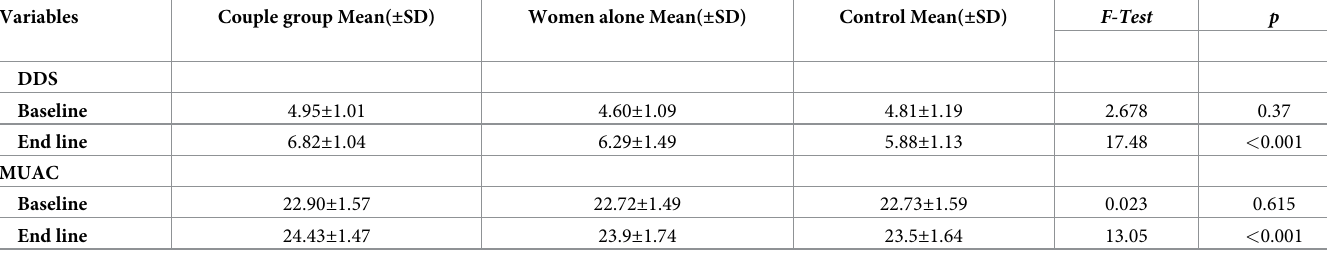
Table 2. Comparison of the Mean DDS and MUAC among the pregnant women ILU Aba Bor Zone, Southwest Ethiopia, 2019/20. Variables